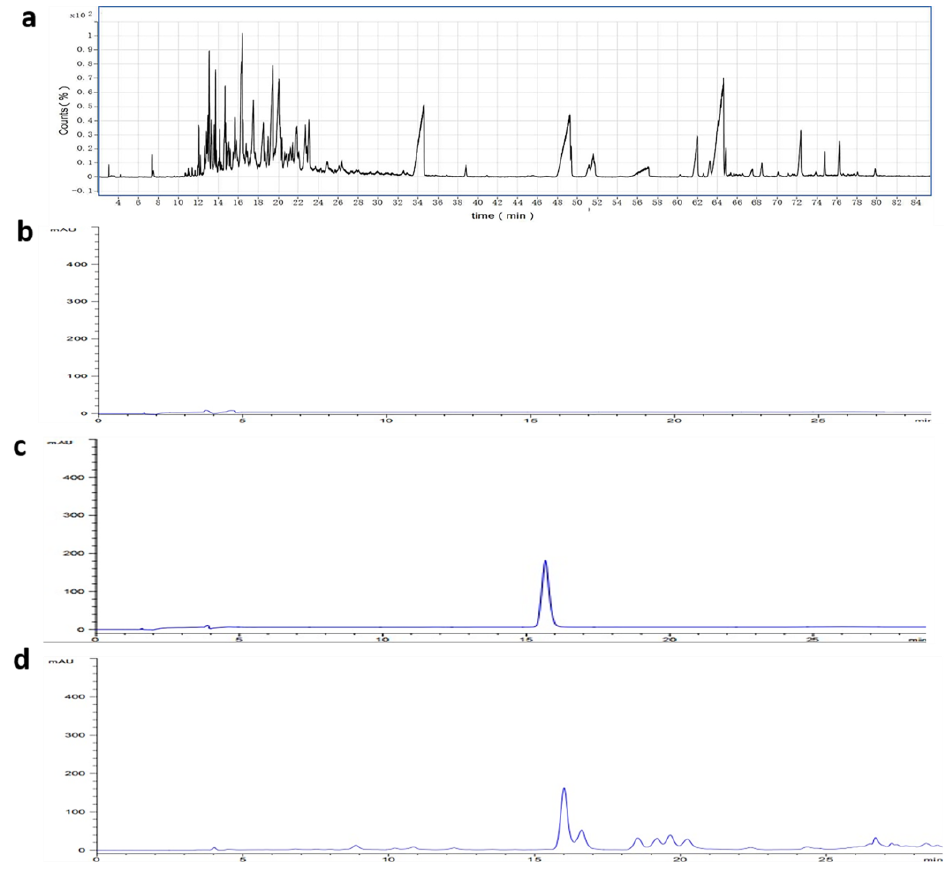
Figure 1. GC – MS total flow diagram of the AEO and HPLC diagram of agarotetraol. (a) The GC – Figure 1. GC–MS total flow diagram of the AEO and HPLC diagram of agarotetraol. ( a ) The GC–MS MS total flow diagram of AEO; (b) HPLC chart of blank control; (c) HPLC chart of agarotetraol total flow diagram of AEO; ( b ) HPLC chart of blank control; ( c ) HPLC chart of agarotetraol standard; standard; (d) HPLC chart of EA. ( d ) HPLC chart of